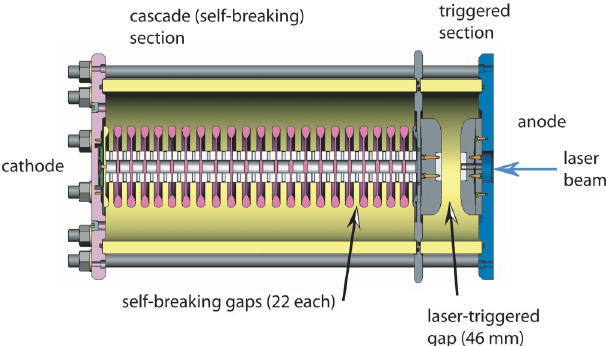
FIG. 2. (Color) Cross section of the 5.4 MV LTGS utilized in the refurbished Z